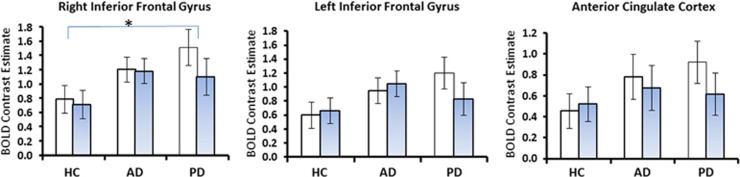
ROI response during the GNG task: mean ‘stops-go’ BOLD contrast estimate within each ROI for the placebo (white bars) and the GSK598809 (gray or blue when in color) sessions. Error bars indicate within-subject SEM (Cousineau and O’Brien, 2014). *Main effect of group, significant at a Bonferroni corrected value of p<0.017. A full color version of this figure is available at the Neuropsychopharmacology journal online.